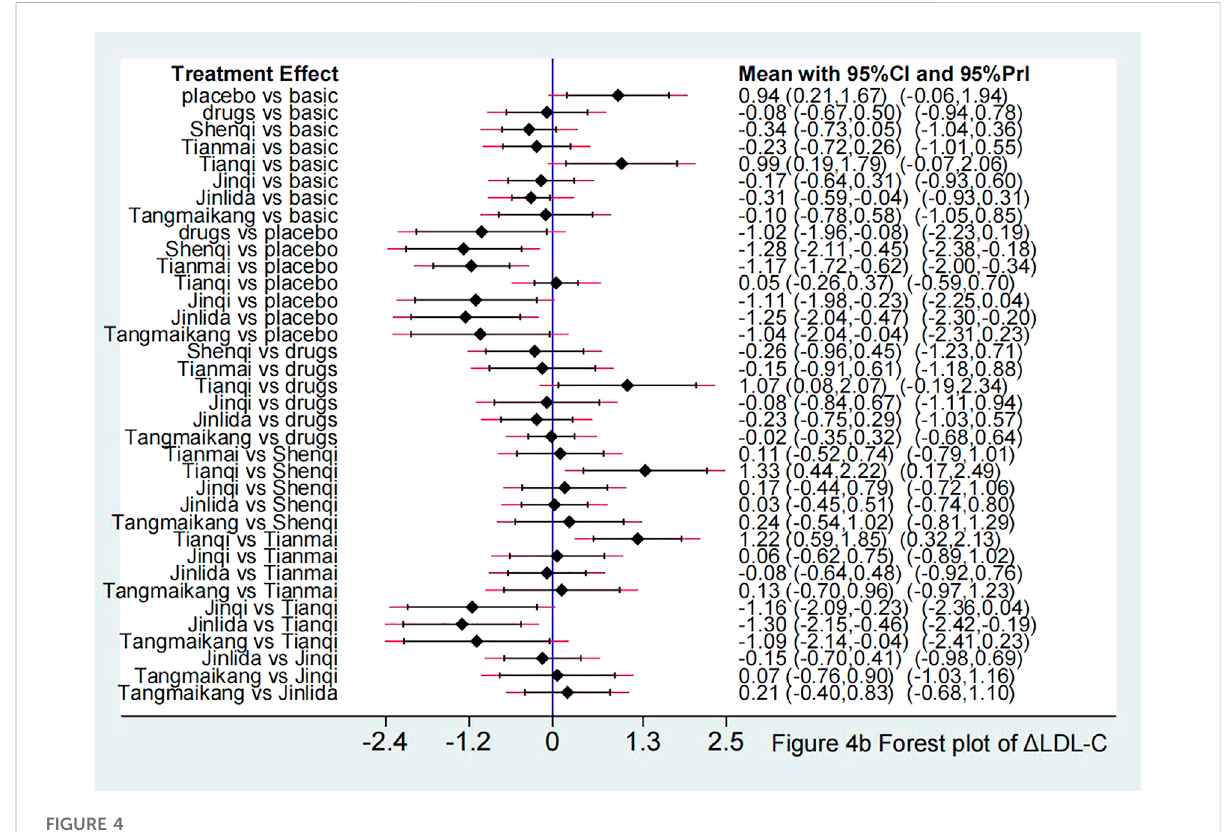
FIGURE 4 (A) Forest plot in Δ